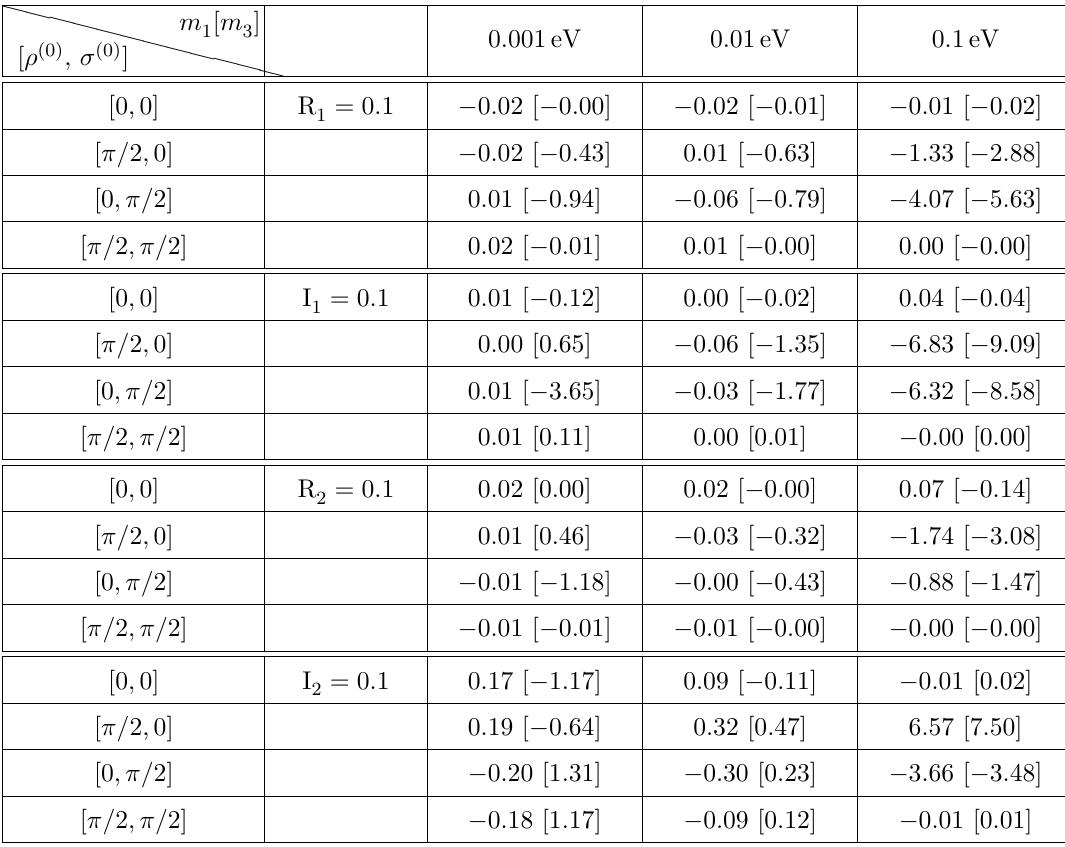
Table 4 . Some representative values of (cid:1) (cid:27) (induced by R respectively) at m (cid:26) (0) and (cid:27) (0) with (cid:14) (0) = (cid:0) (cid:25)=